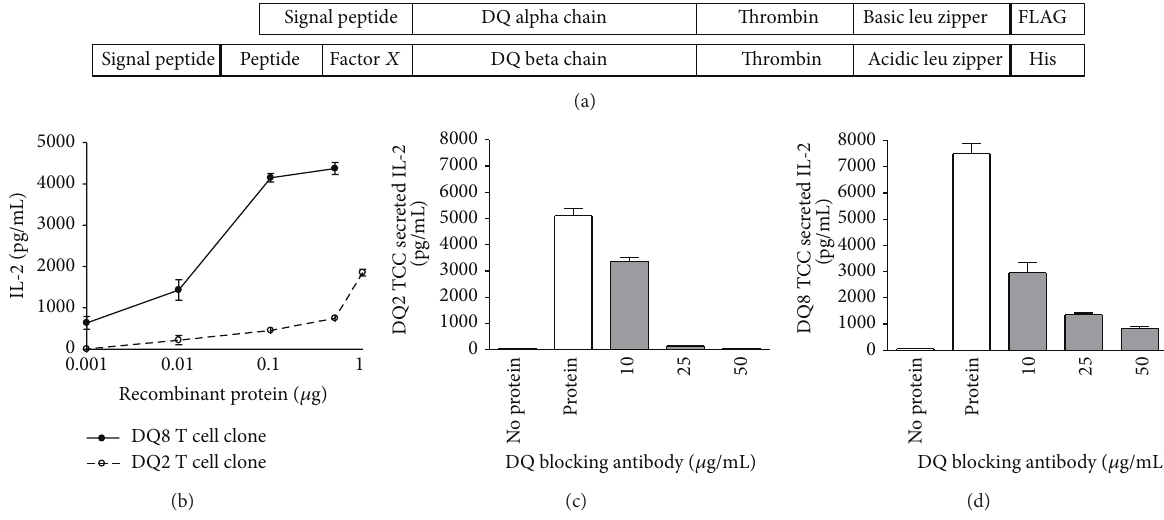
Figure 1: Recombinant DQ8 and DQ2 proteins with gliadin epitopes stimulate T cell clones. (a) Diagrams of the constructs used to produce recombinant protein for deamidated 𝛼 -gliadin p1E, p9E/DQ8, and 𝛼 -I gliadin/DQ2. The amino acid sequence of the 𝛼 -gliadin peptide in DQ8 is QQYPSG E GSFQPSQ E NPQ and the 𝛼 -I gliadin peptide (QLQPFPQP E LPY) with DQ2. Thrombin, TEV, and PreScission are protease cleavage sites incorporated into the protein constructs. (b) T cell clones restricted to either DQ8 or DQ2 produce IL-2 in response to the deamidated 𝛼 -gliadin/DQ8 or 𝛼 -I gliadin/DQ2 recombinant protein, respectively. (c) The DQ2 and (d) DQ8 T cell responses can be blocked in a dose dependent manner with a monoclonal DQ antibody.